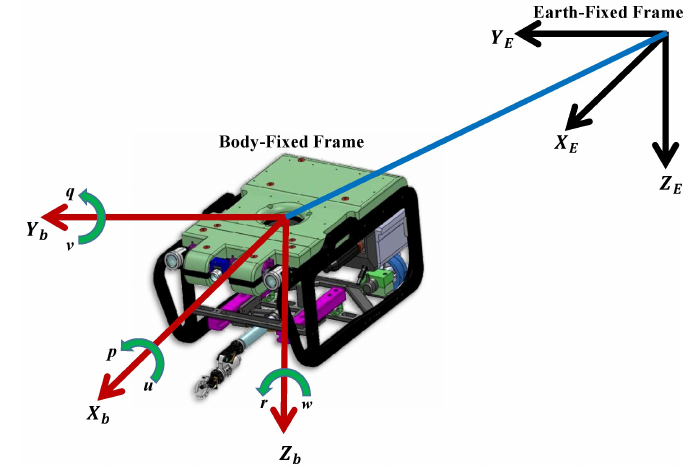
Figure 1. Frame coordinates of an underwater